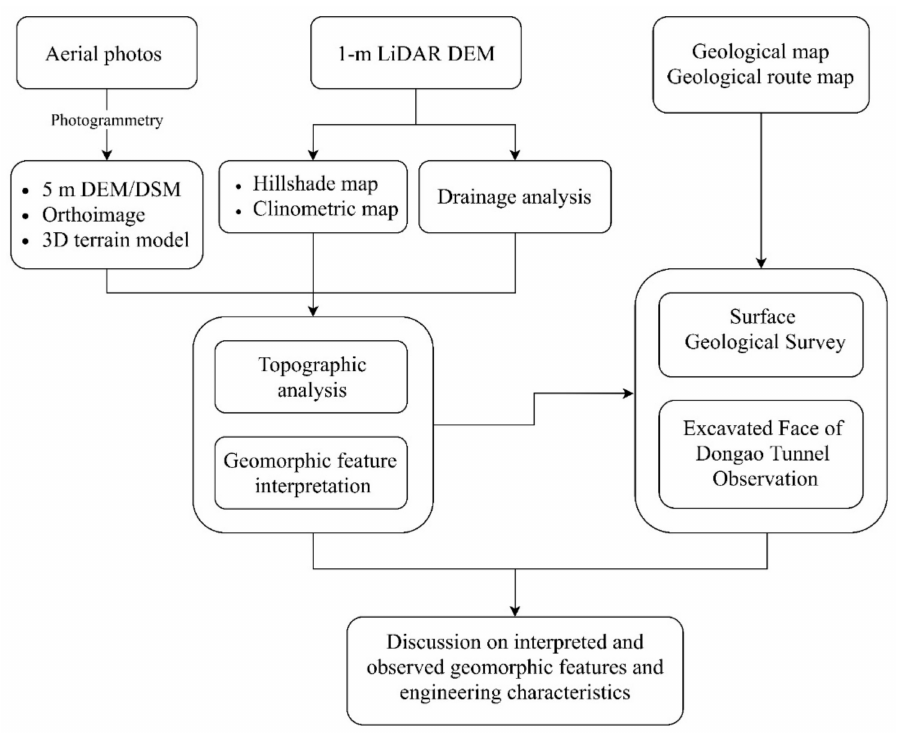
Figure 3. Research